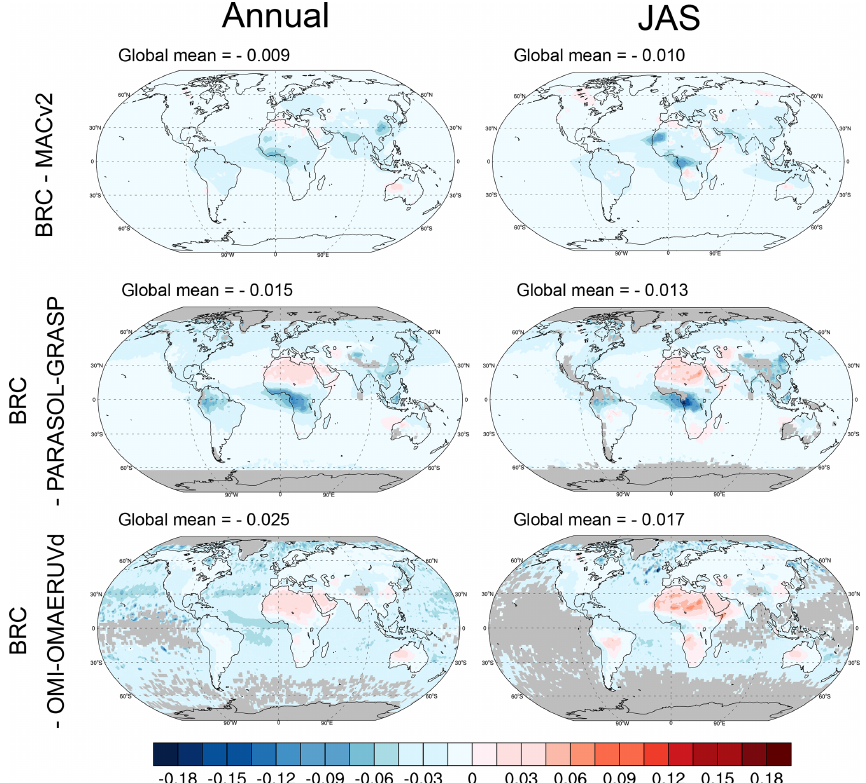
Figure A8. Same as Fig. A4 but for the AAOD (440nm; see Tables 2 and 3 for details).